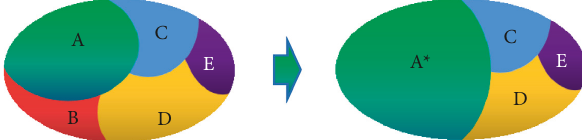
Figure 4: Adjacency diagram before and after